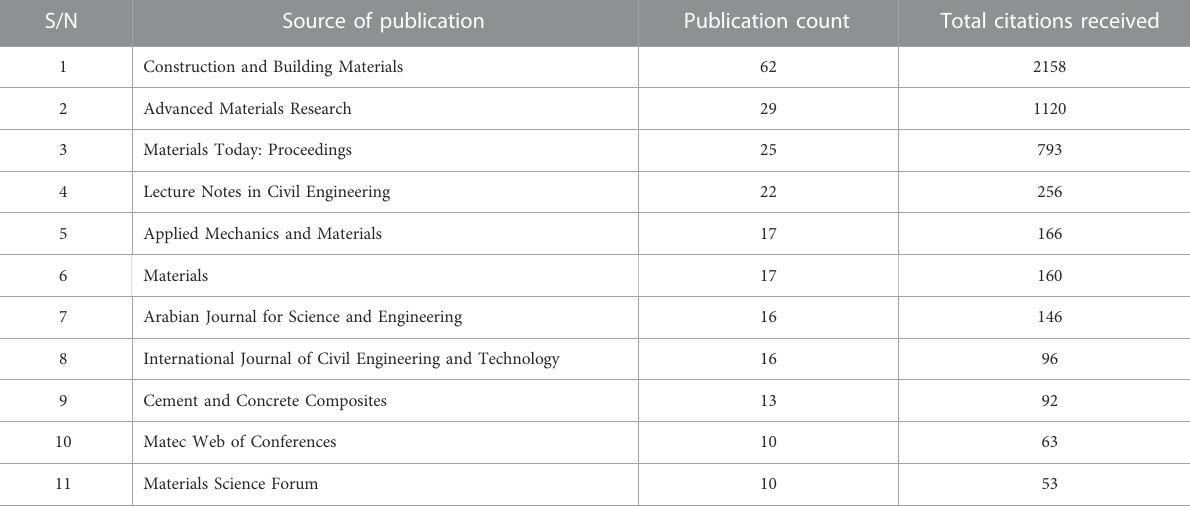
TABLE 1 Publication sources having a minimum of 10 publications on mineral fi ber-reinforced concrete research.